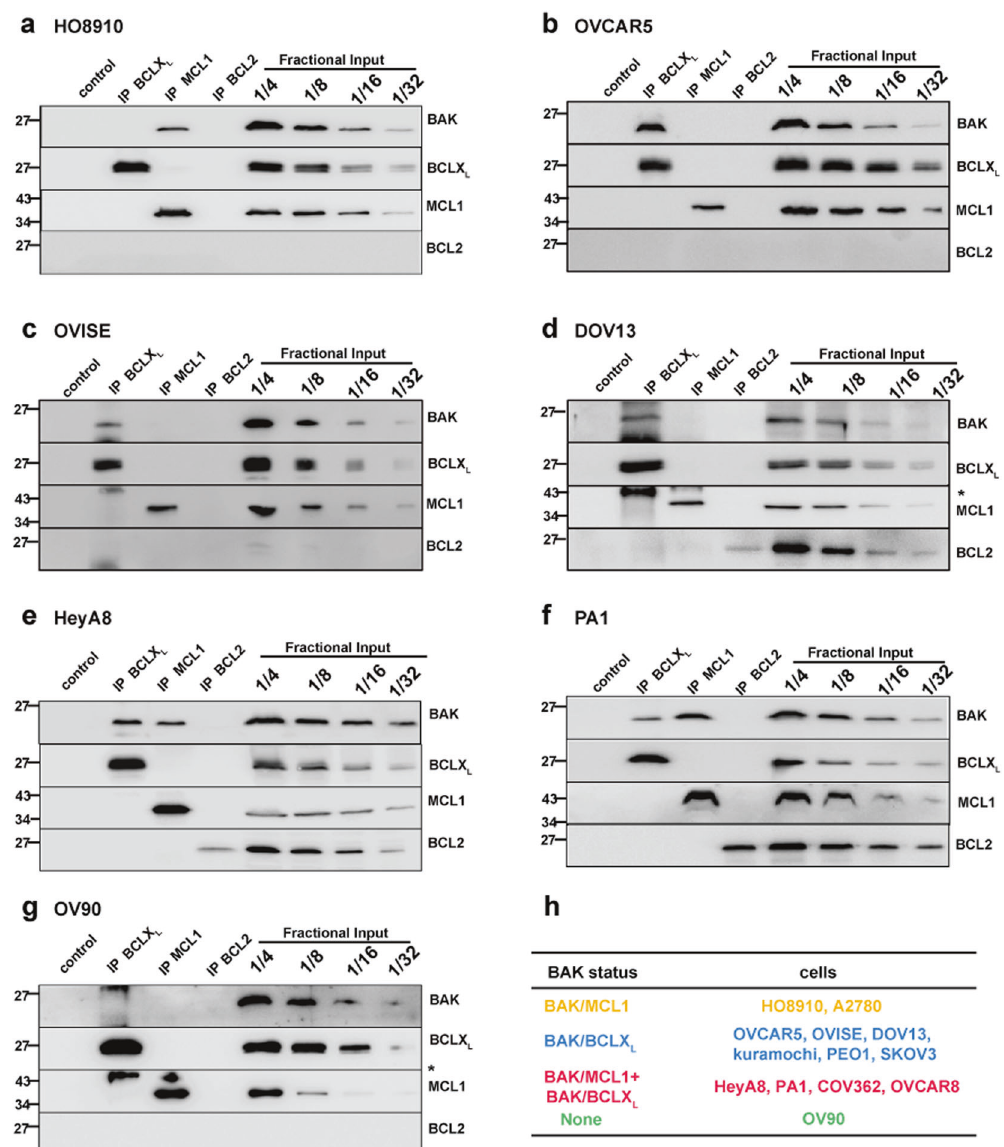
Fig. 1 BAK partial activation status varies among ovarian cancer cell lines. a – f CHAPS lysates of ovarian cancer cell lines HO8910 ( a ), OVCAR5 ( b ), OVISE ( c ), DOV13 ( d ), HeyA8 ( e ), PA1 ( f ), and OV90 ( g ) were immunoprecipitated (IP) with antibodies to BCLX L , MCL1, or BCL2, and compared with serial dilutions of the input. IPs with normal rabbit IgG served as negative controls. *, heavy chain. h Classi fi cation of BAK partial activation status of the ovarian cancer cell lines according to the IP results. BAK status was de fi ned as BAK bound to MCL1 only (BAK/ MCL1, in orange), BAK bound to BCLX L only (BAK/BCLX L , in blue), BAK bound to MCL1 and BCLX L (BAK/MCL1 + BAK/BCLX L , in red), and BAK not bound to any indicated antiapoptotic BCL2 proteins (None, in green), respectively. The boundary-value to de fi ne BAK as partially activated was set as 5% of total cellular BAK bound to BCL2, BCLX L , or